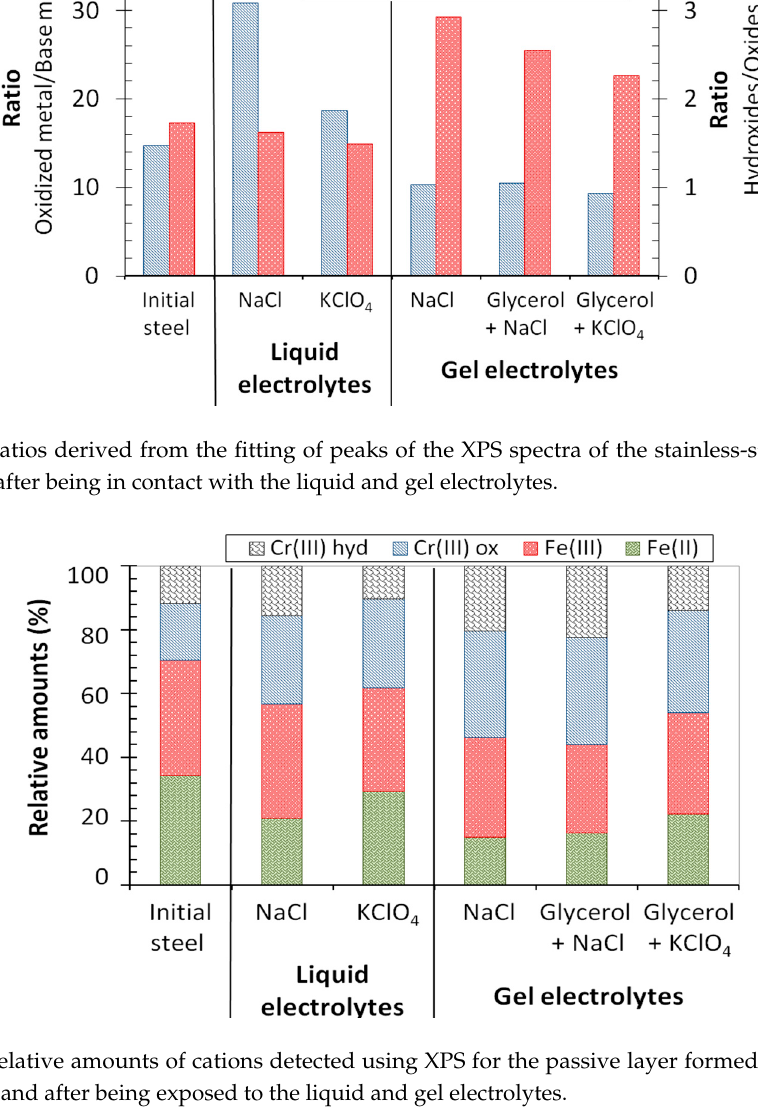
Figure 5. Relative amounts of cations detected using XPS for the passive layer formed on stainless steels in air and after being exposed to the liquid and gel electrolytes.